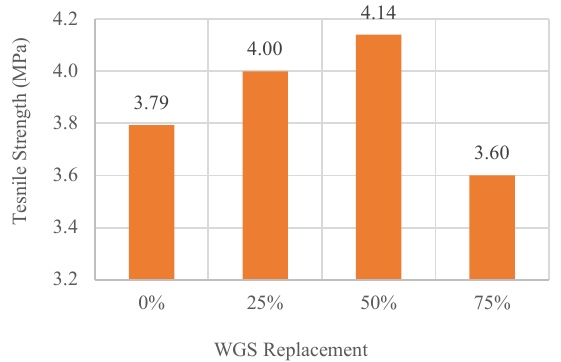
Figure 12. Split tensile strength at 28 days. Table 3. The ratio between Split Tensile Strength and Compressive Strength.